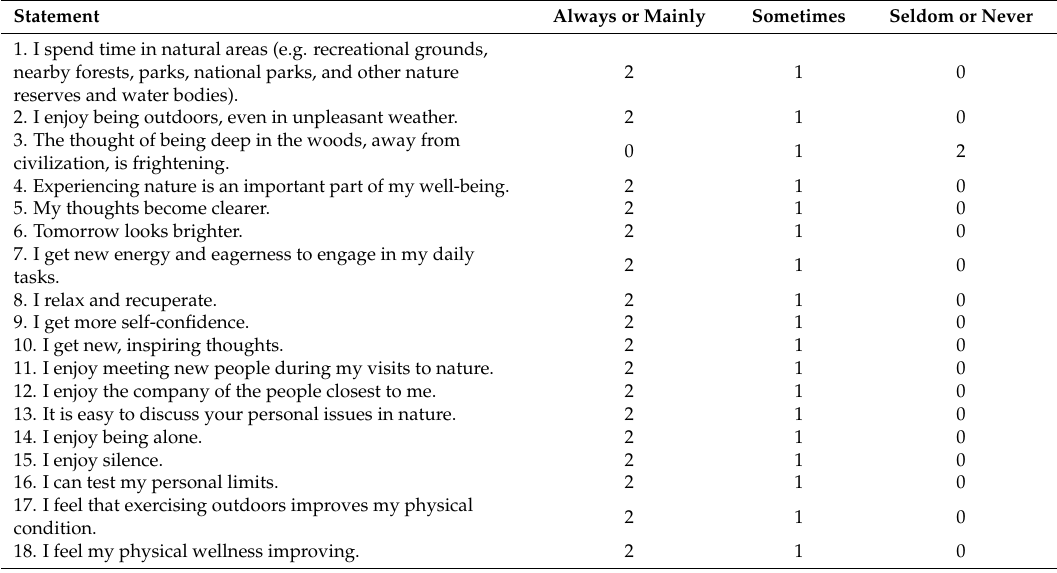
Table A1. Scoring of nature